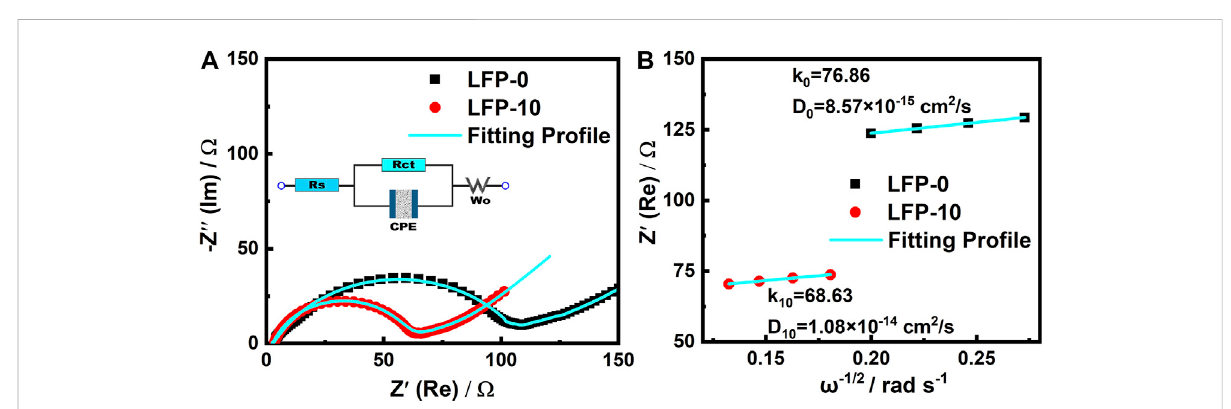
FIGURE 8 (A) Nyquist plots of electrodes LFP-0 and LFP-10; (B) diffusion coef fi cients of LFP-0 and